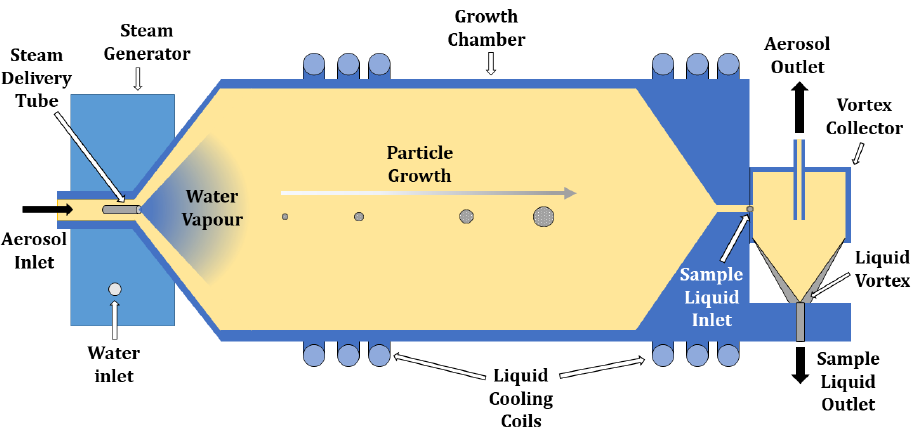
Figure 2. PINQ insoluble aerosol collector (IAC) diagram, highlighting major components such as the aerosol input, steam generator, growth chamber, and vortex collector. (Figure adapted from Brown et al.